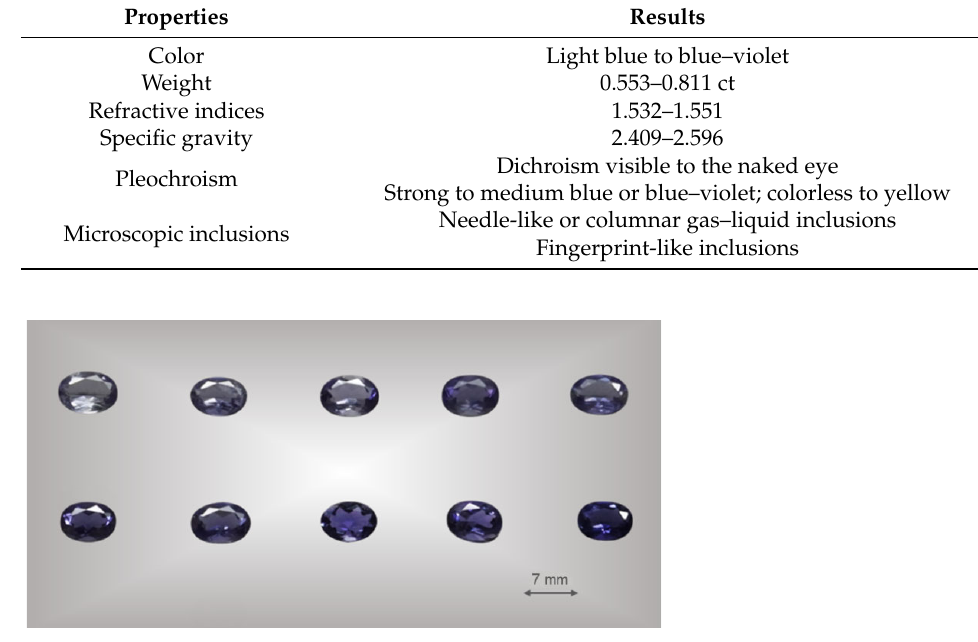
Figure 1. Some of the samples used in this study under standard D65 light. All samples are taken from the tabletop.